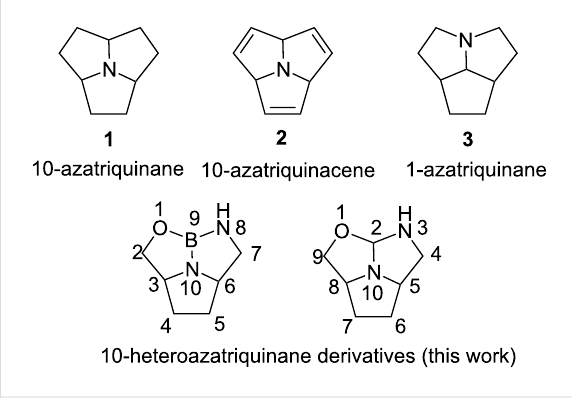
Figure 1: The structures of azatriquinanes and azatriquinacene.